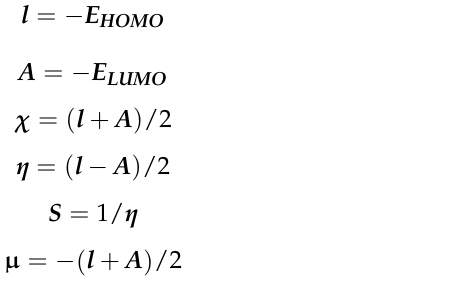
Table 7. The calculated E HOMO , E LUMO , and molecular descriptors of compounds 2 , and 3a – g .